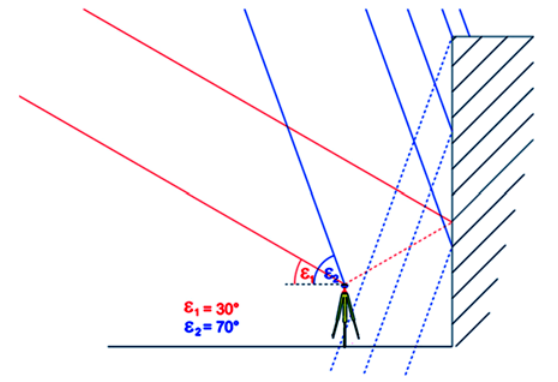
Fig. 6. Geometric model – multipath: VSB-TUO sports hall (point